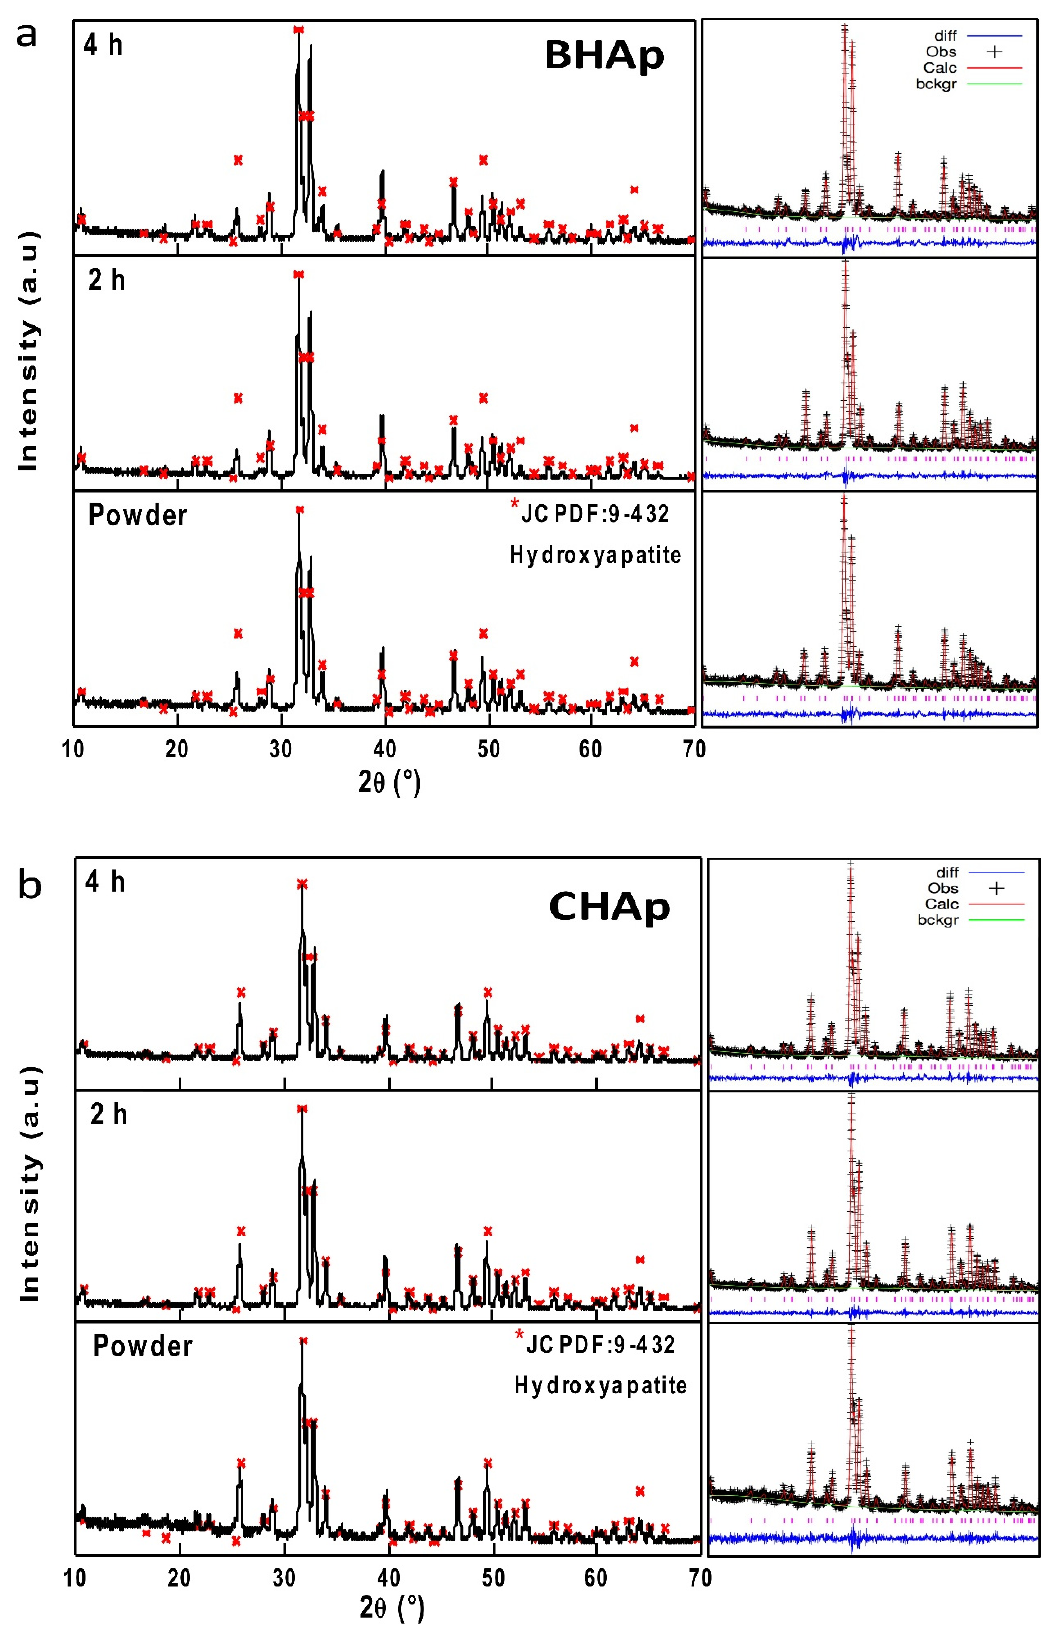
Figure 3. XRD patterns and Rietveld refinements of: BHAp ( a ); and CHAp ( b ) powders and sintered ceramics after 2 h and 4 h. A single phase of HAp (JCPDF 9-432) was identified in BHAp and CHAp.